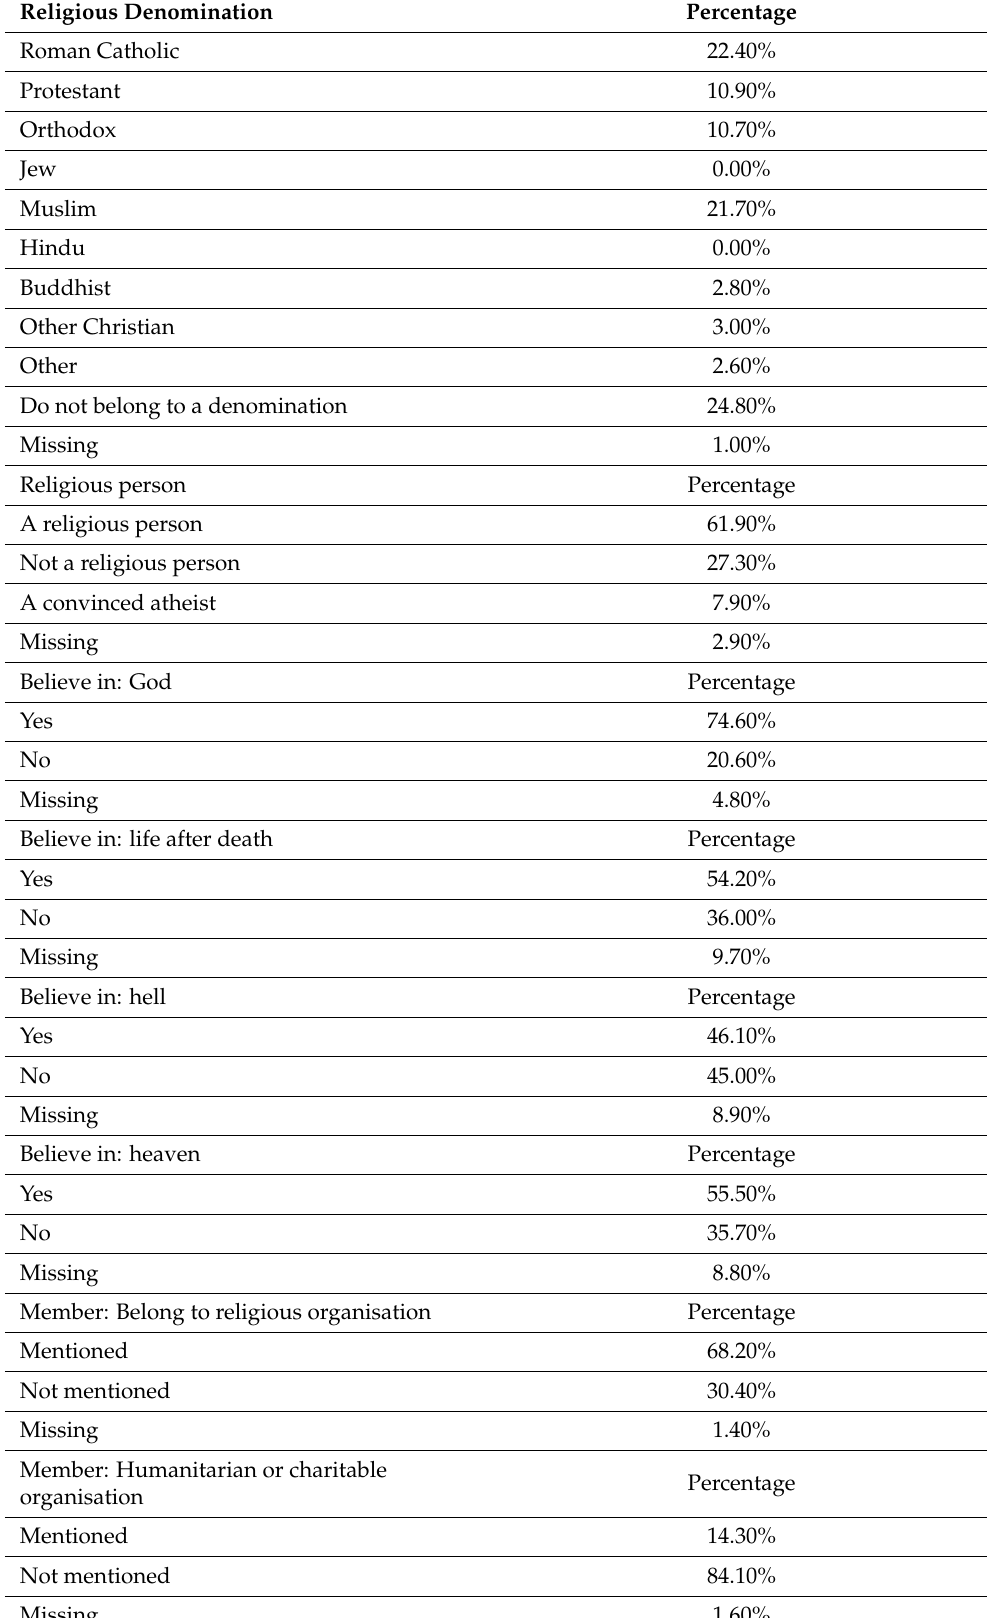
Table A2. The distribution of nominal variables in our